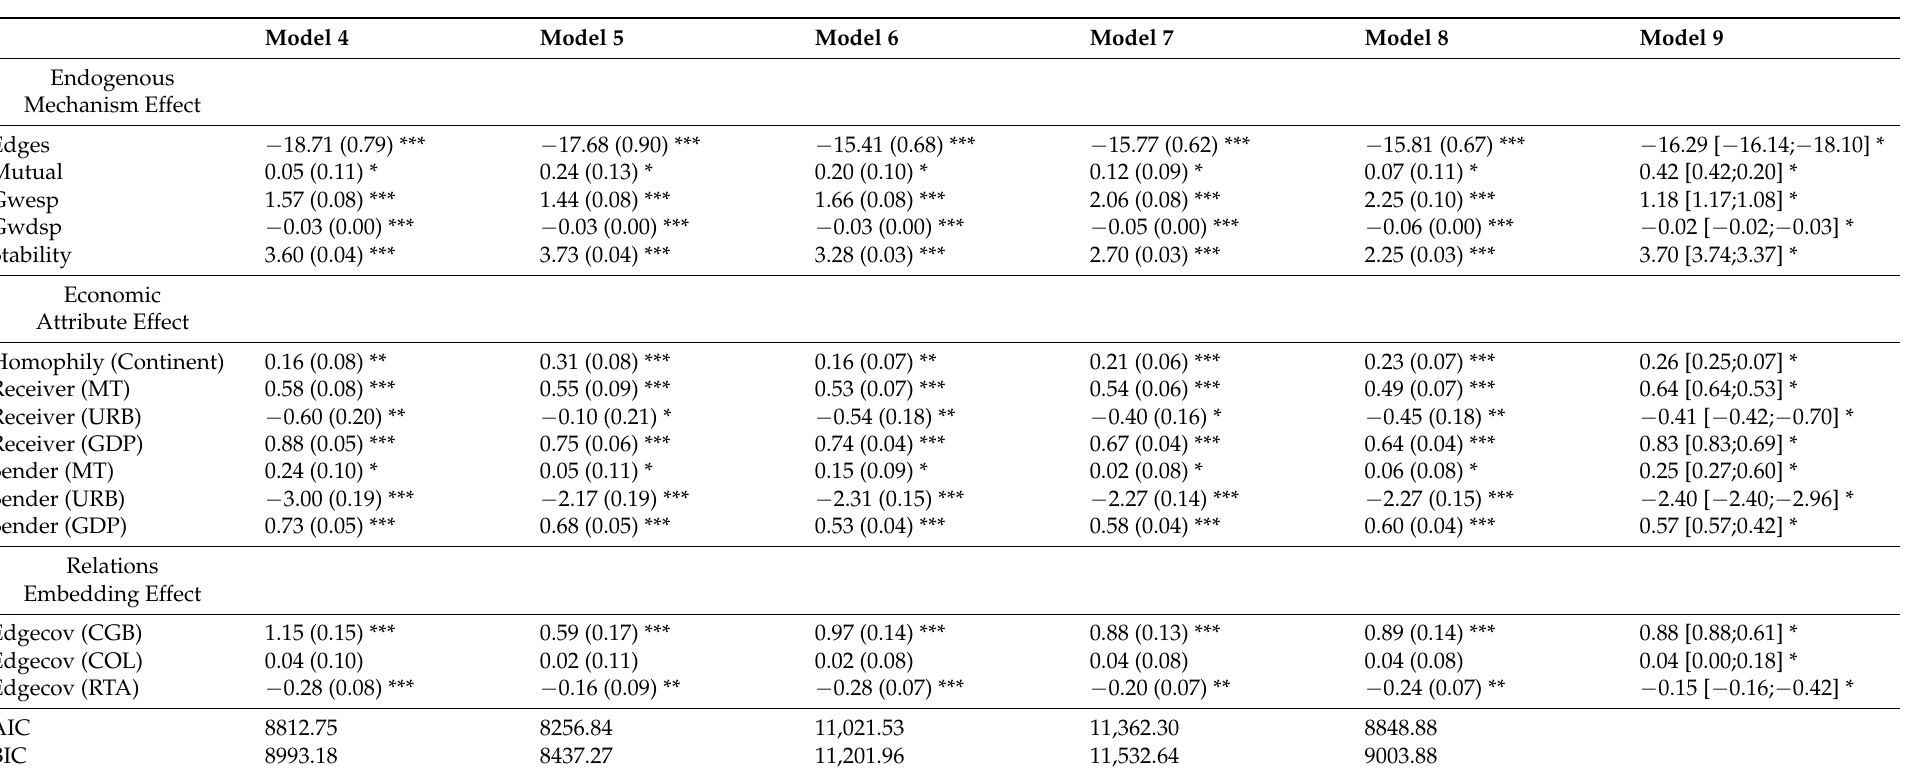
Table 4. Robustness test results of